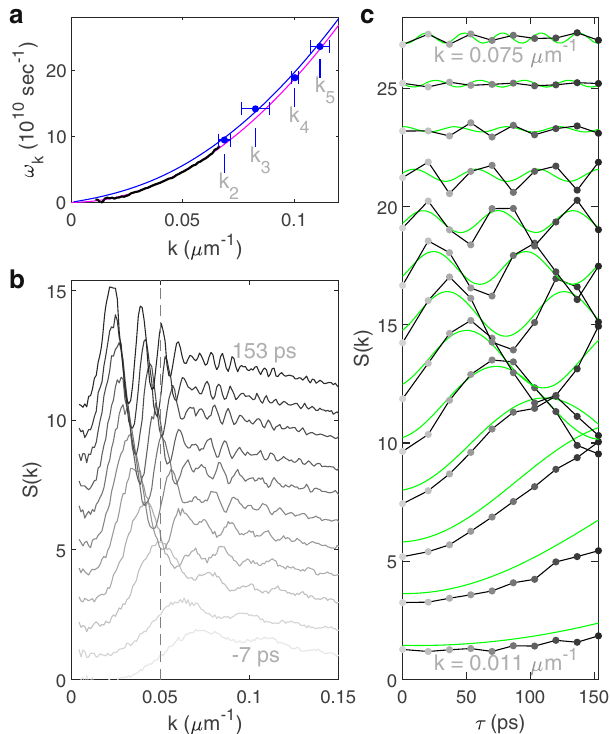
Fig. 4 Individual modes of the analogue cosmological particles. a The dispersion relation. The blue points are derived from the k p in Fig. 3a. The error bars indicate one standard deviation. The black curve is obtained by sinusoidal fi ts to the gray curves in ( c ). The magenta curve is the free- particle dispersion relation. The blue curve is the dispersion relation in the interacting fl uid of light. b The static structure factor at various times. The curves are from Fig. 3a, and are shifted vertically. The vertical dashed line is used to fi nd the values in ( c ). c Each curve shows the τ -dependence of a de fi nite k , given by the values along a vertical line in b , such as the dashed line. The grayscale is the same as in ( b ). The k -values shown are equally spaced by 5.4 × 10 -3 µ m -1 . The green curves are computed with Eq. (2). Each pair of black and green curves has been shifted vertically. NATURE COMMUNICATIONS| (2022) 13:2890